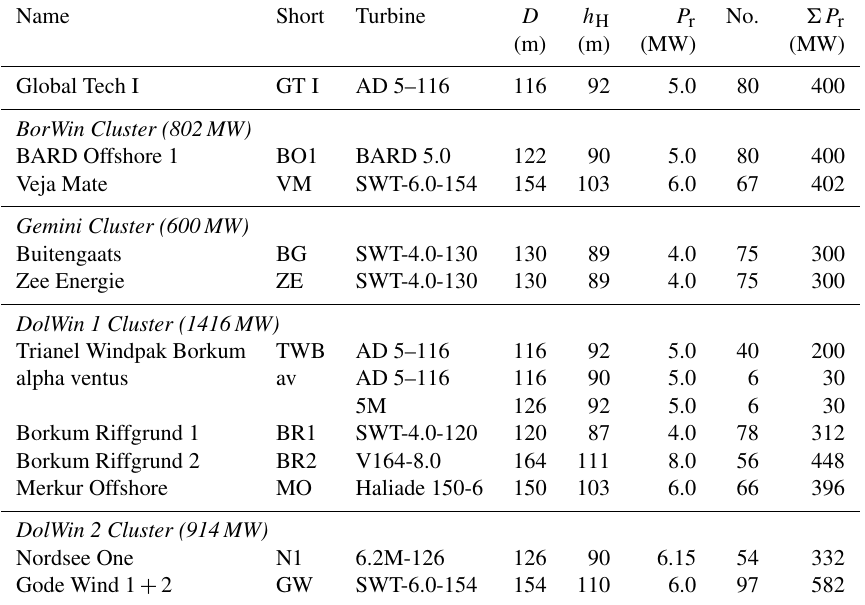
Table 1. Overview of offshore wind farms considered in this work (as of June 2019). The wind farms Borkum Riffgrund 2 (Orsted, 2018) and “Merkur Offshore” (Merkur Offshore, 2018) were in the commissioning phase and partly fed into the grid during our measurements; therefore, they are marked with smaller symbols in the relevant plots in this paper. D : rotor diameter, h H : hub height, P r : rated power per turbine, No.: number of turbines per wind farm, (cid:54)P r : rated power of wind farm. The numbers for the hub height are related to different reference levels, namely lowest astronomical tide (LAT), mean sea level (MSL) or just “over water”. These differences are not further considered here since the difference between LAT and MSL is typically around 2m in the North